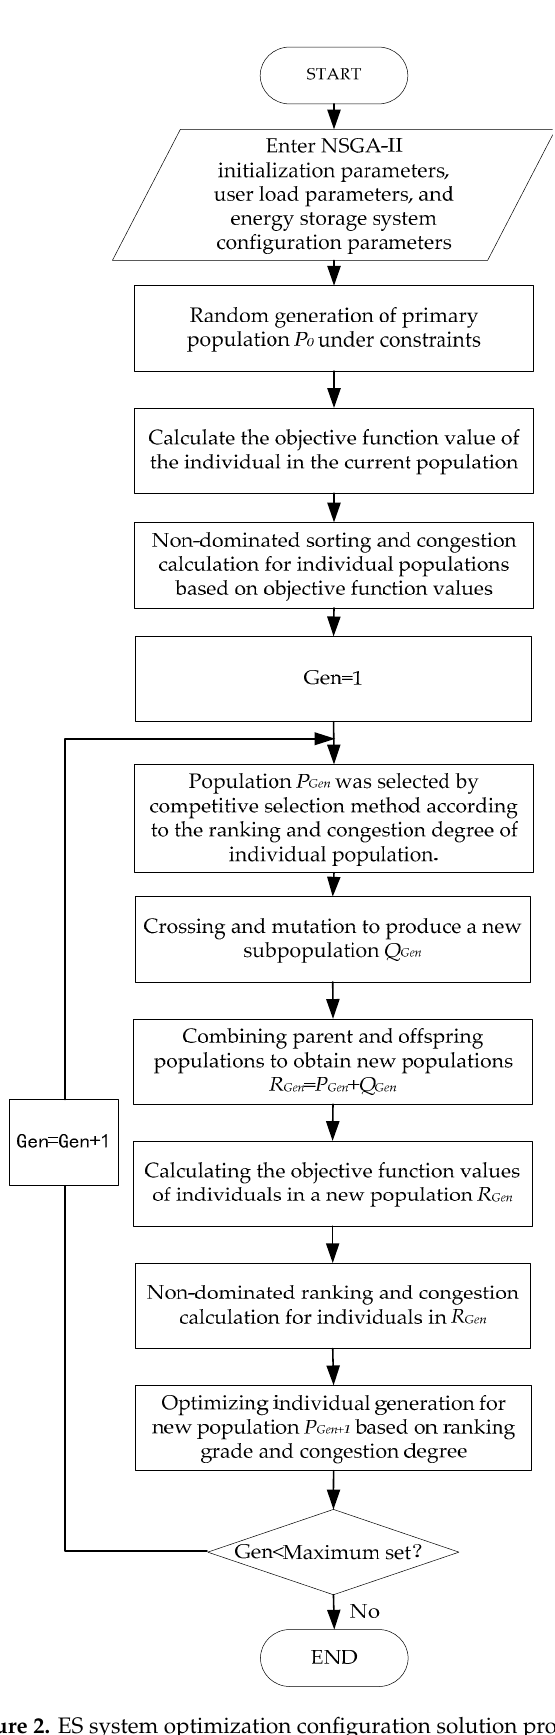
Figure 2. ES system optimization configuration solution process.